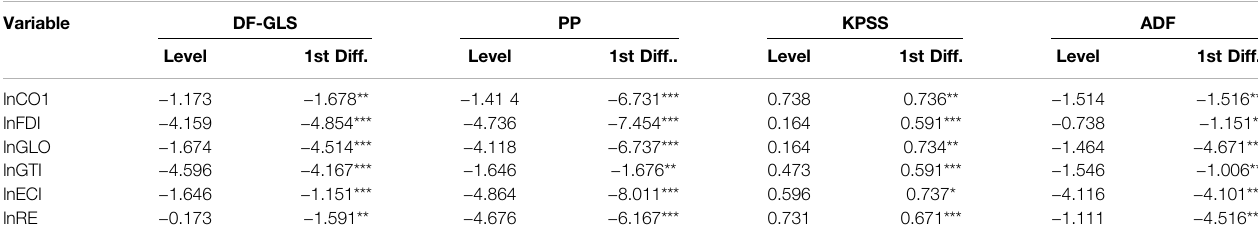
TABLE 4 | Unit root tests results.